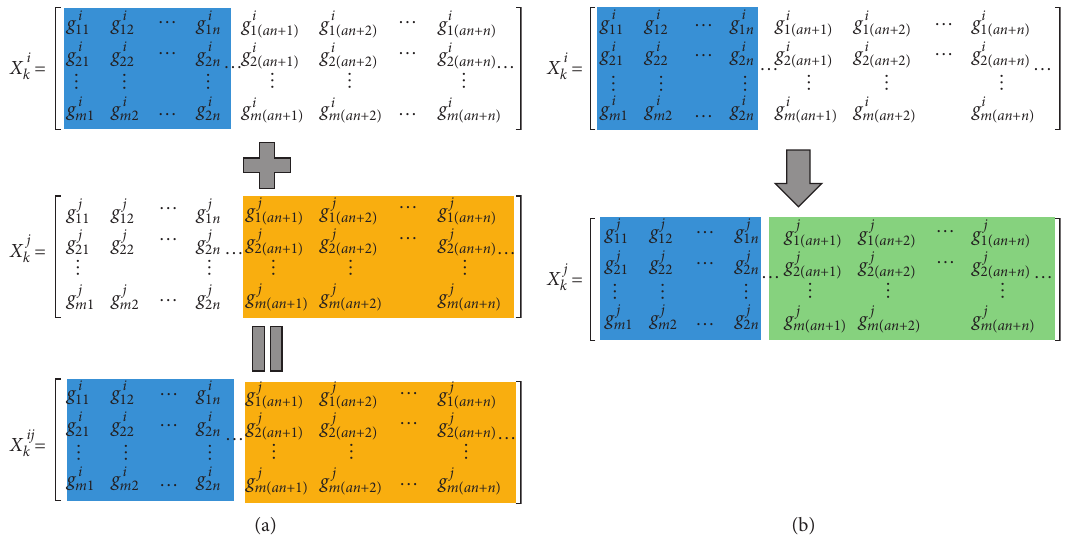
Figure 9: Genetic operators: (a) crossover operator; (b) mutation